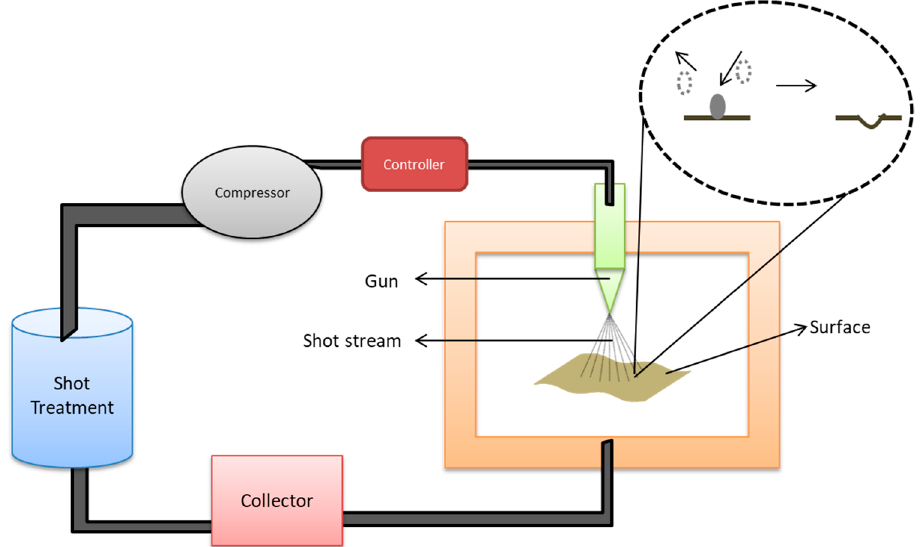
Figure 17. Schematic representation of shot peening process for modifying the surface properties. Compressed air consisting of shot particles is expressed through the gun on the surface which induces a compressive stress. The excess shots are collected and reused.